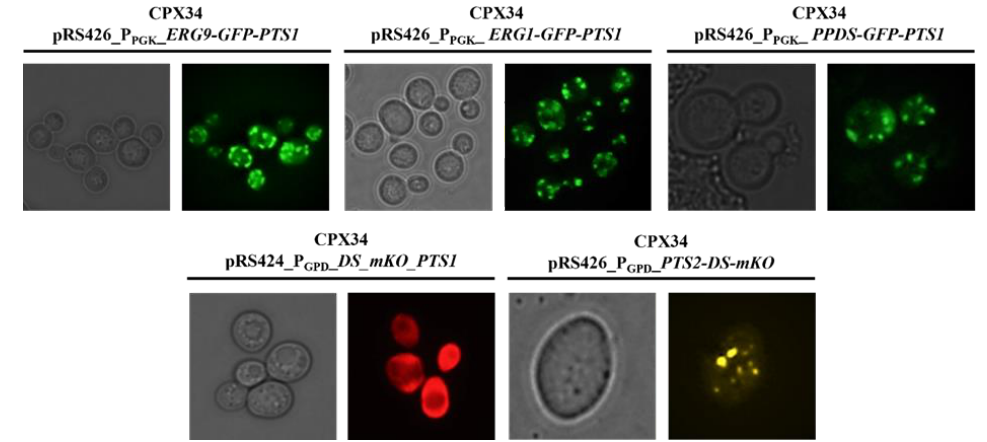
Figure 6. Fluorescence microscopy images of CPX34 strains engineered to target pathway enzymes into the peroxisomes. Peroxisome-engineered CPX34 cells harboring ERG9-GFP-PTS1, ERG1-GFP- PTS1, DS-mKO-PTS1, PTS2-DS-mKO, or PPDS-GFP-PTS1 fusion protein were cultured in the syn- thetic defined medium with 2% glucose for 12 h and then subjected to fluorescence microscopy.